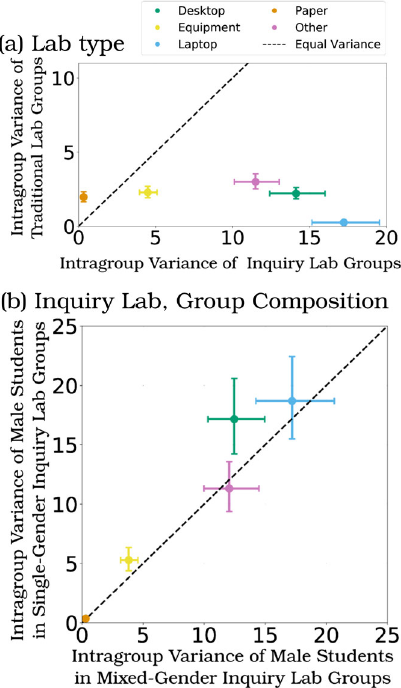
FIG. 8. Intragroup variances of the relative behaviors among students, signifying the amount of task division within groups. Each plot shows VAR( Δ N ) for all student profiles contained within the labeled lab and group types along with their Bayesian confidence intervals. (a) Comparing across lab types, the intra- group variances are remarkably larger in the inquiry lab groups than in the traditional lab groups for all codes besides paper, indicating a greater range of behaviors and an increase in task division. (b) Within the inquiry labs, the intragroup variances are comparable among groups of differing composition suggesting that similar degrees of task division were taking place. (Female single-gender groups not included due to insufficient